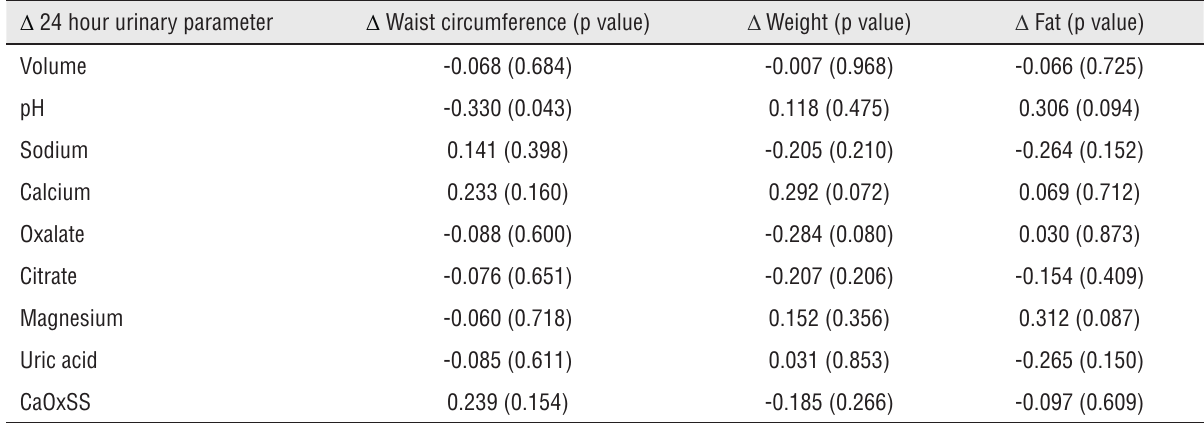
Table 3 - Spearman’s correlation between change of obesity parameters and change of calcium oxalate urinary stone risk factors. Δ 24 hour urinary